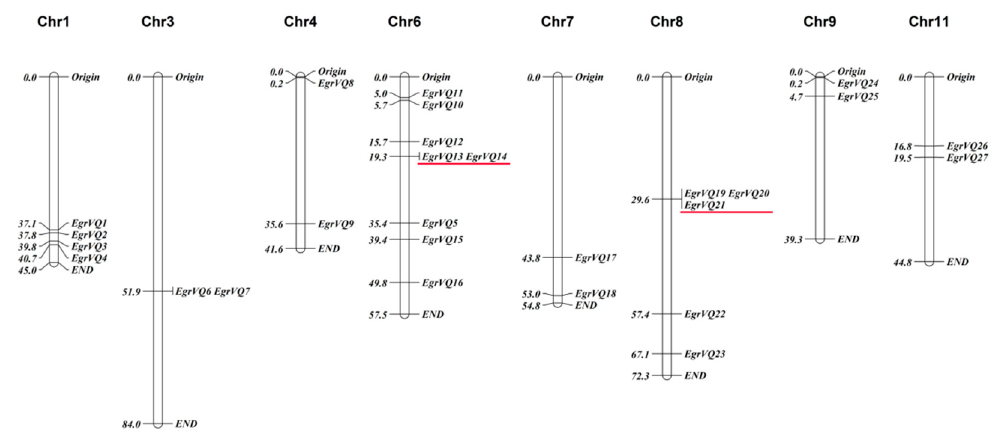
Figure 1. Chromosomal location of E. grandis VQ genes. Chromosome numbers were indicated above each chromosome. The size of a chromosome was indicated by its relative length. Gene positions and chromosome sizes were given in megabases (Mb) to the left of the figure. Tandem duplicated genes were underlined in red. Table 2. The summary of paralogous ( Egr–Egr ) and orthologous ( Egr–At , Egr–Os and Egr-Pt ) gene pairs.